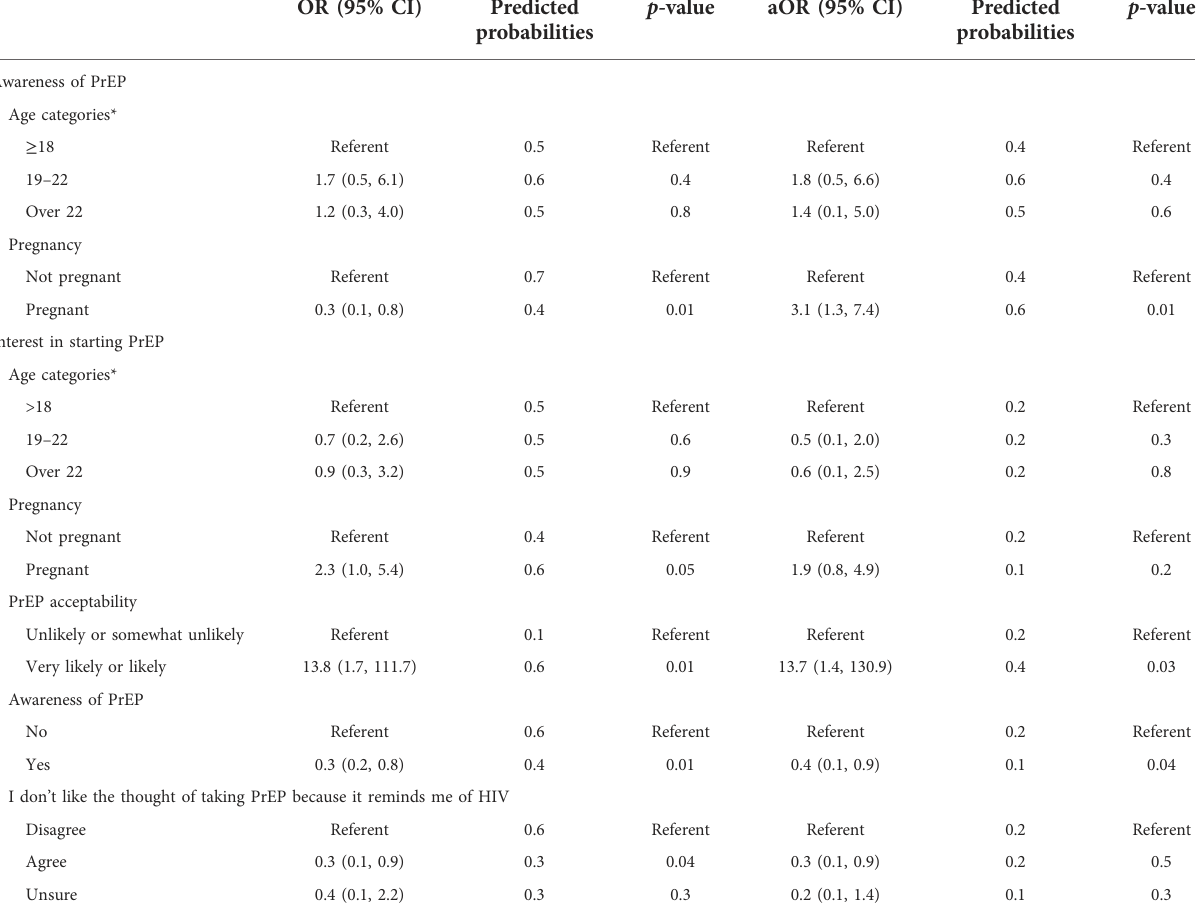
TABLE 2 Statistically signi fi cant associations between study variables and awareness of PrEP or interest in starting PrEP adjusted for age